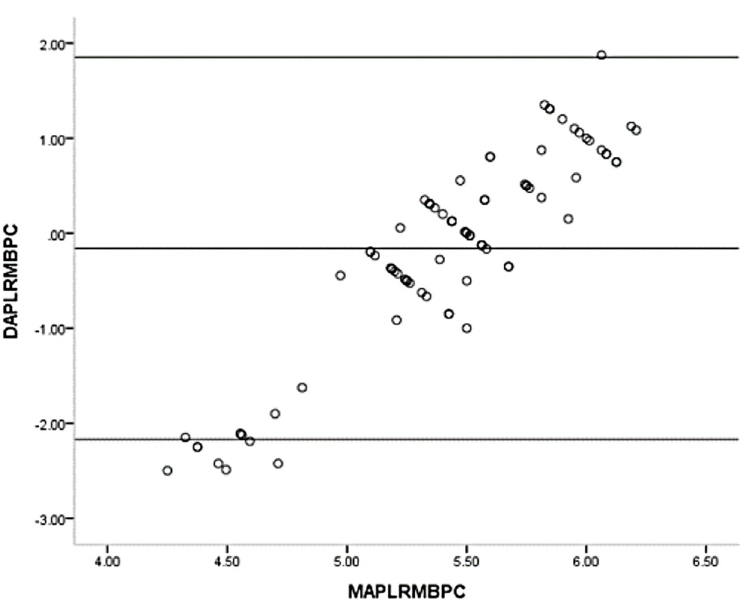
Fig 6. Bland-Altman plot of the APL and the RM before pupillary contraction. APL = advanced penlight; RM = refractometer; DAPLRMBPC = difference of advanced penlight and refractometer before pupillary contraction; MAPLRMBPC = mean of advanced penlight and refractometer before pupillary